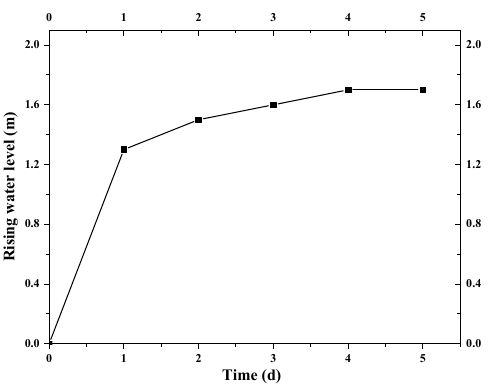
Figure 6. Layout of reinjection well.